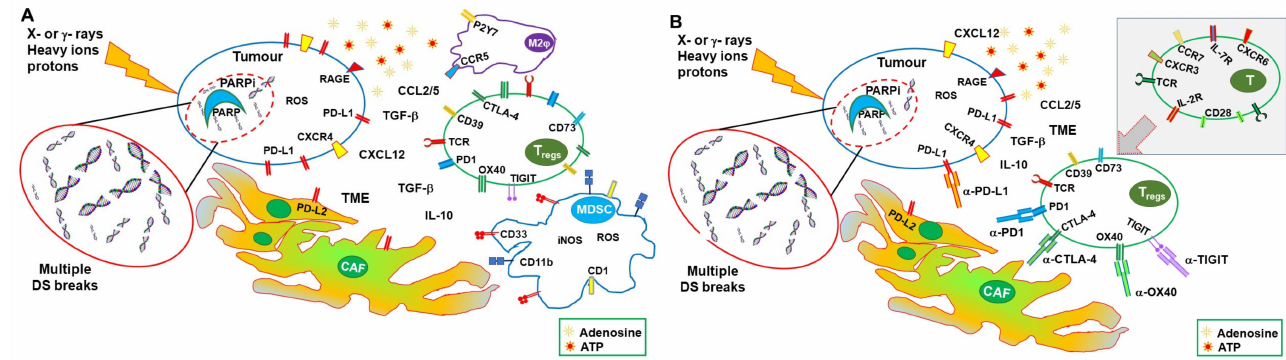
Figure 2. Correcting the immune suppressive effects of RT and PARPis into a hot stimulating TME by targeting immune checkpoints. ( A ) RT induces immune-suppressive effects through several mechanisms other than simple cell toxicity. RT upregulates the expression of chemokines (CCL2 and CCL5) and cytokines (IL-10 and TGF β ), which sustain recruitment of MDSC and Treg cells, polarization of M2 macrophages and Treg cells, and inhibitory effects on the immune response. RT also induces the expression of PD-L1 in tumor and immune cells, as well as of PD-L2 in cancer- associated fibroblasts (CAF). Furthermore, PARPis sustain regulatory T cell (Treg) recruitment and PD-L1 upregulation. A suppressive TME is also favored by an excessive release of ATP, which is rapidly degraded to adenosine by CD39 and CD73, compromising the antitumor immune response. ( B ) The addition of ICIs to therapy can sustain the beneficial effects of RT and PARPis, leading to a synergic immune stimulation. A hot immunogenic TME allows DC to take up tumor-associated antigens (TAA) and migrate to draining lymph nodes, where anti-CTLA-4 ICIs, by lowering the threshold for activation, sustain the generation of effector CD4 and CD8 T cells. Effector T cells can migrate (upper corner) to the tumor site and exert their functions. At the tumor site, anti-PD-1 and/or anti-PD-L1 ICIs prevent the inhibition of the effector T cells by PD-L1-expressing tumor (and nontumor) cells. Both anti-CTLA-4 and anti-PD-1 ICIs can contrast the action of Treg cells, unleashing the antitumor immune